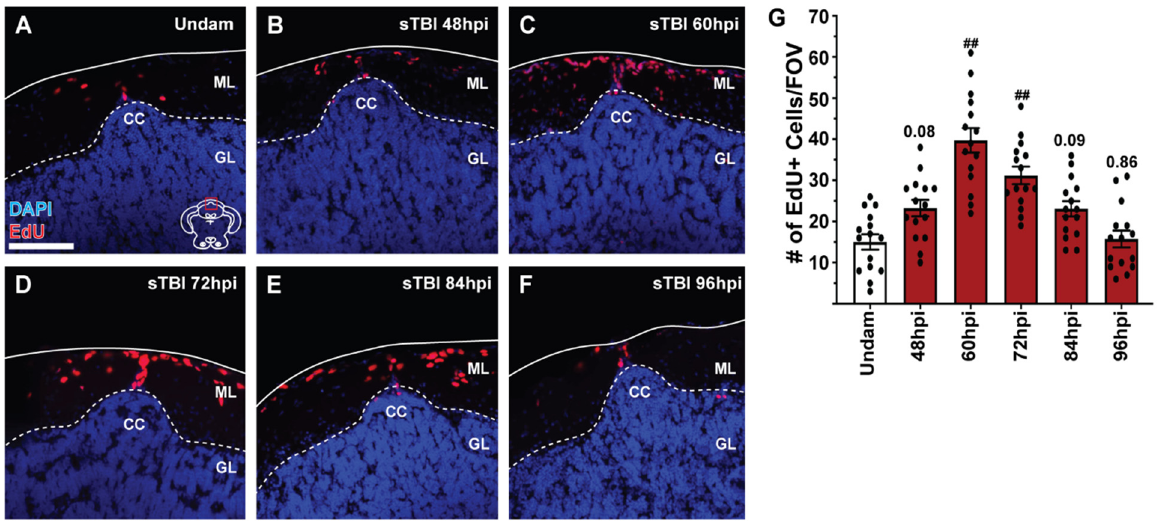
Figure 7. Blunt-force TBI induces cell proliferation at the cerebellar crest. ( A – F ) Confocal images of coronal cerebellar sections of undamaged and sTBI fish that were IP-injected with EdU 12 h prior to collection. EdU-labelled cells (red) are present radiating from the cerebellar crest in all panels. ( G ) Quantification of the number of EdU-positive cells at the CC at various timepoints following sTBI (n = 15). Increased EdU labeling, relative to undamaged fish, was observed as early as 48 hpi, with peak proliferation at 60 hpi. Solid lines in A – F denote tissue boundary, while dotted lines denote internal anatomical boundaries. Cerebellar crest, CC, granule cell layer, GL, molecular layer, ML. Scale bar = 100 µm for A – F . Mean ± SEM is depicted in G . Statistical analysis was performed using a One-way ANOVA followed by a Tukey’s post-hoc test. # p < 0.05, ## p < 0.01.